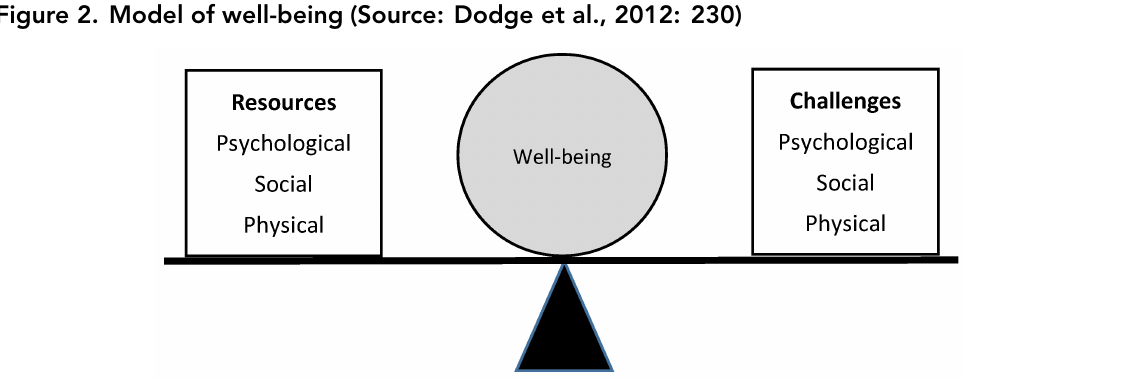
Figure 2. Model of well-being (Source: Dodge et al., 2012: